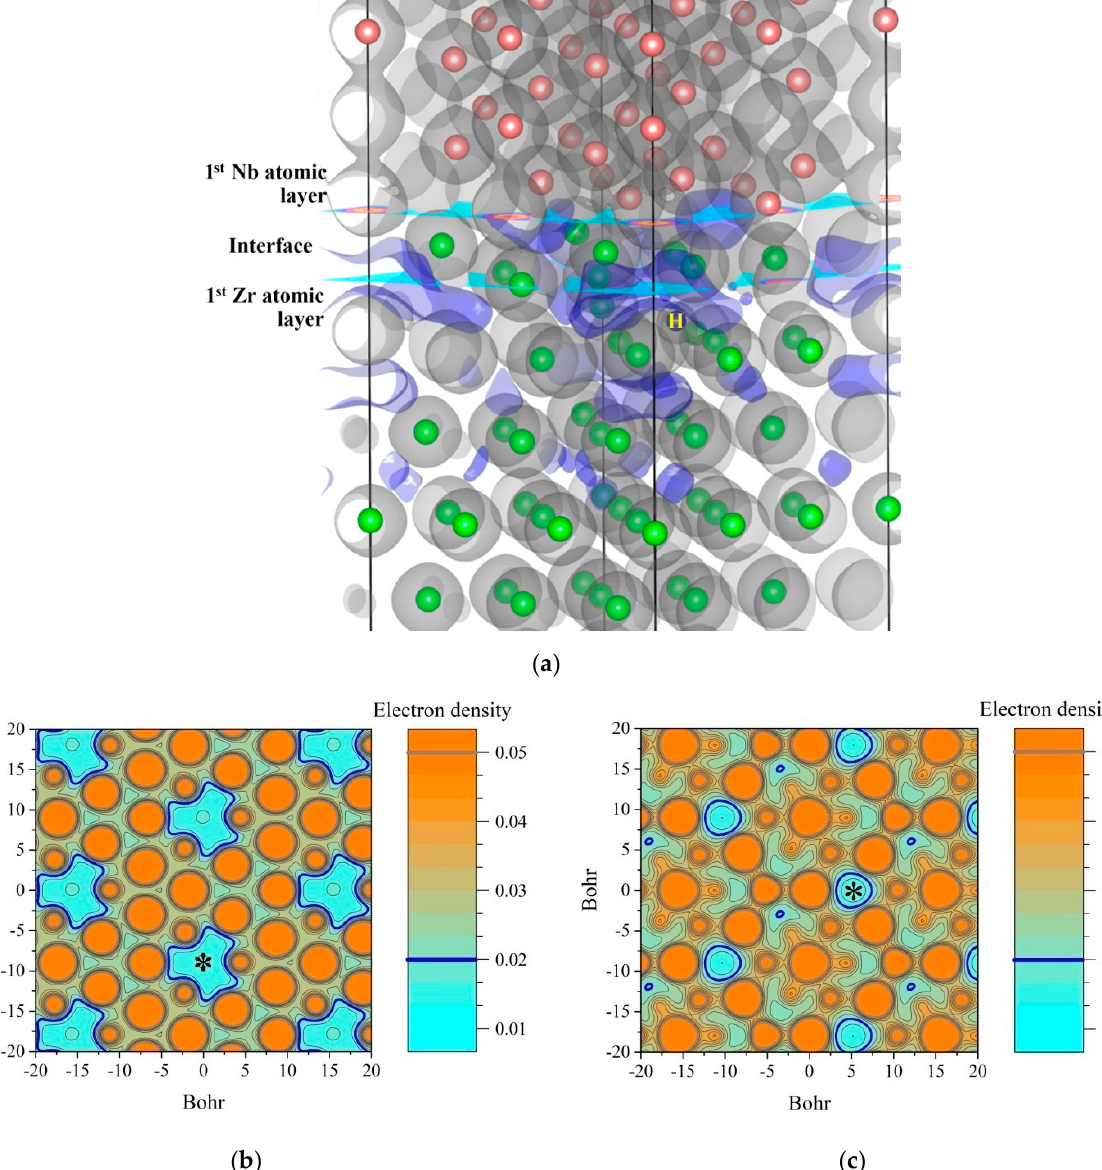
Figure 13. Electron density distribution in the interface vicinity of Zr 63 Nb 40 H slab with H atom in octahedral (O1) site ( a ) and in the first Zr ( b ) and Nb ( c ) atomic layers. The blue and gray isosurfaces in panel ( a ) correspond to a charge density of 0.02 and 0.05 electrons/Bohr 3 , respectively. The areas of a reduced electron density in the Zr ( b ) and Nb ( c ) atomic layers are marked with (*). Color gradation scale in the ( b , c ) panels is given in electrons/Bohr 3 units.